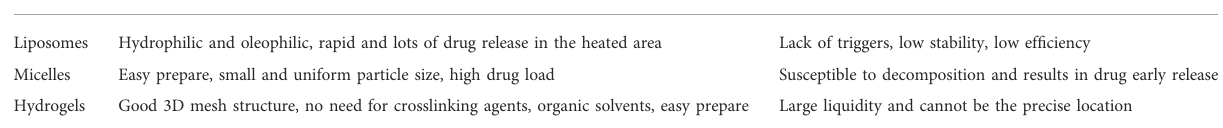
TABLE 1 Characteristics of three kinds of most common PCMs.